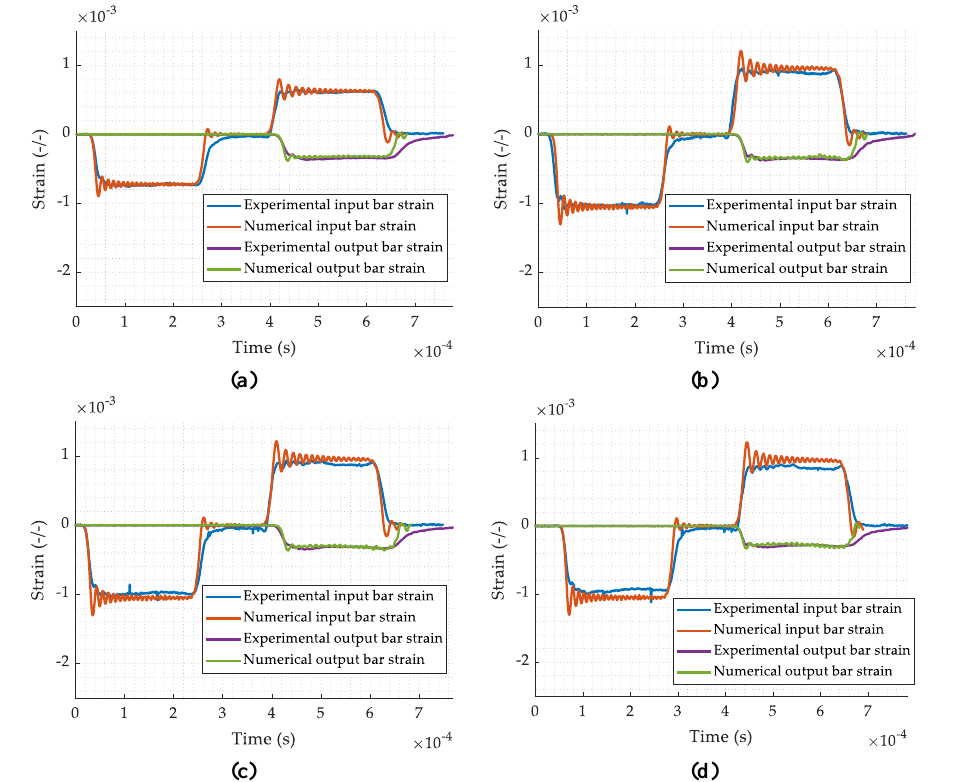
Fig 6. Comparison between the numerically and experimentally obtained strain for: (a) v 1 = 6 m/s at 293 K; (b) v 2 = 11 m/s at 293 K; (c) T 2 = 373 K at 11 m/s; (d) T 3 = 473 K at 11